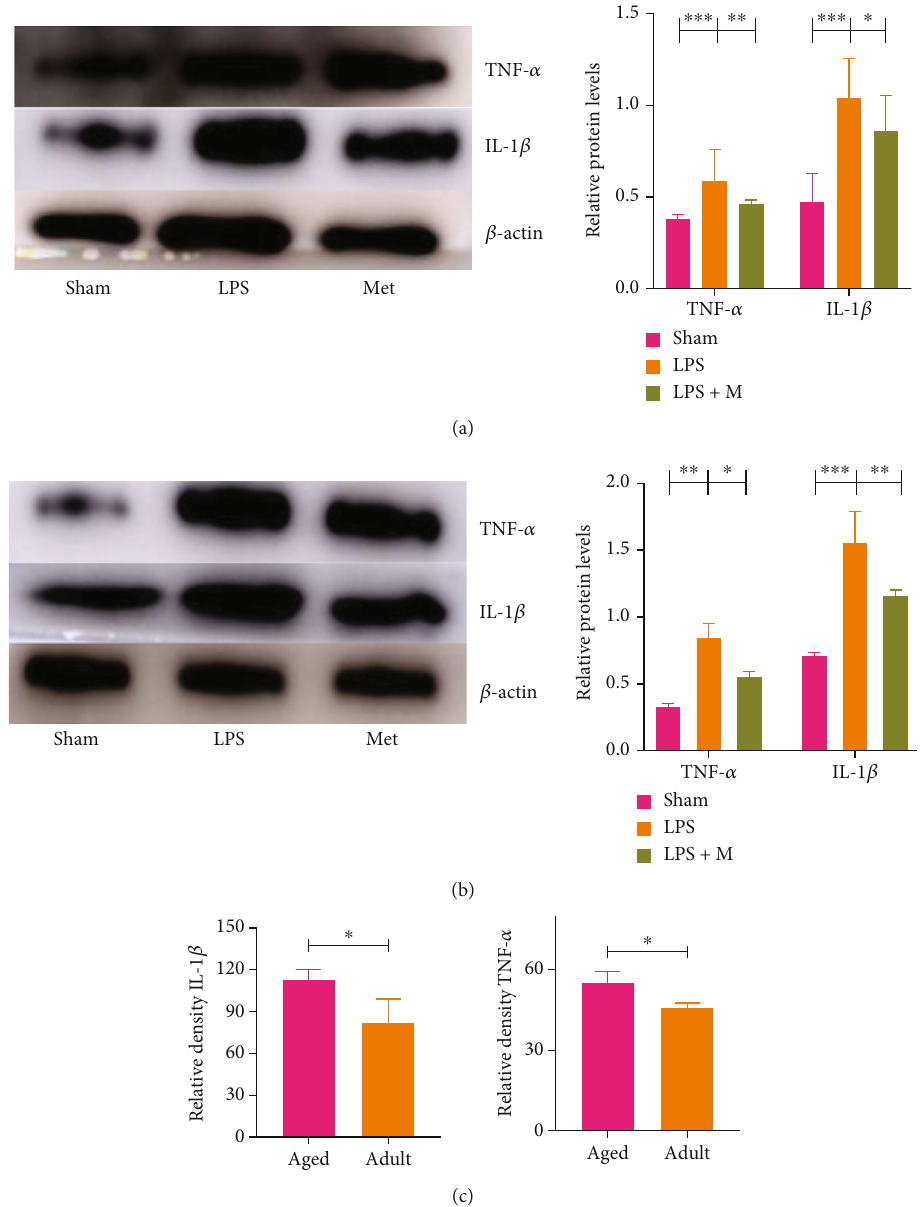
Figure 6: (a, b) E ff ects of metformin on TNF- α and IL-1 β protein levels in LPS-induced SAE mice brain tissue. (c) Comparison of LPS- induced SAE mice treated with metformin between the adult group and the aged group LPS + M group. ∗ p < 0 : 05 , ∗∗ p < 0 : 01 , ∗∗∗ p < 0 : 001 . n = 10 in each group. TNF- α : tumor necrosis factor- α ; IL-1 β : interleukin-1 β ; LPS: lipopolysaccharide; LPS + M : lipopolysaccharide and